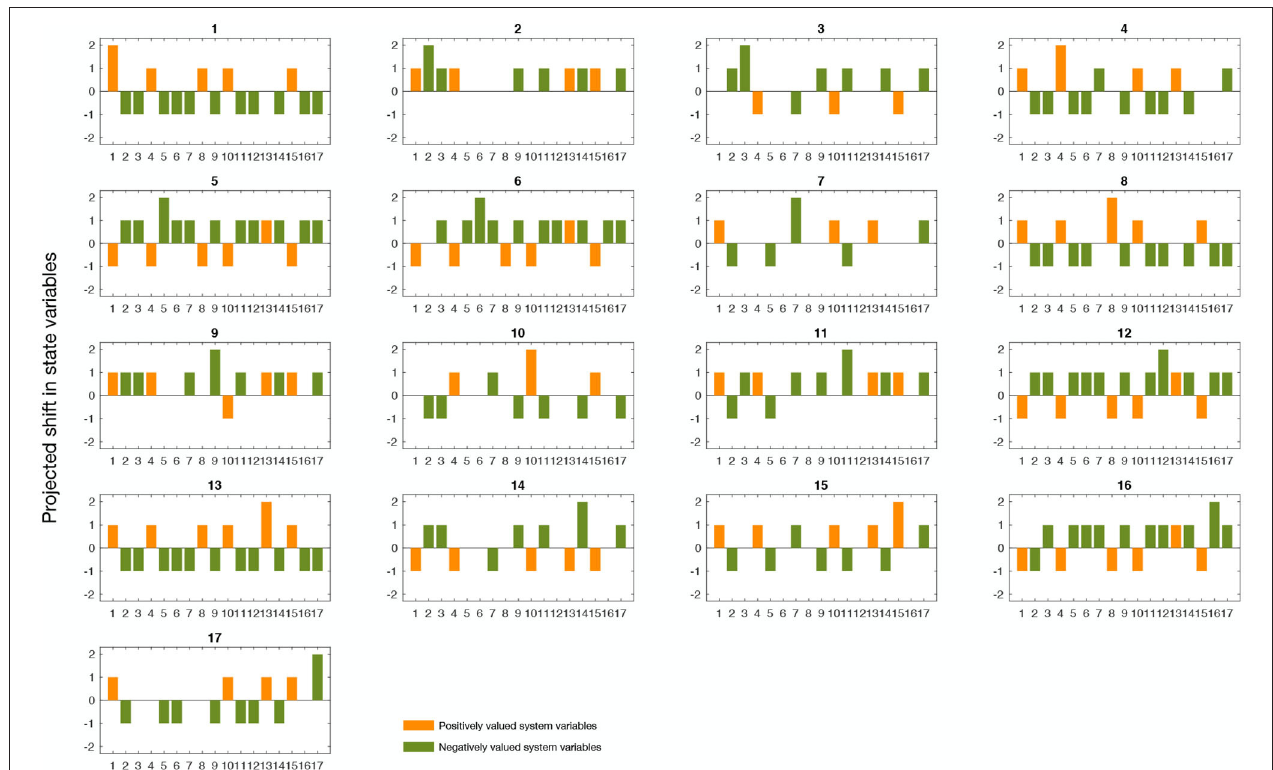
FIGURE 2 | Projected responses of state variables to sustained pressures on each single variable, which is numbered at the top of each plot. For example, the top left plot shows the projected categorical shift (1: weak, 2: strong) in the equilibrium level of each variable (1–17 on x-axis) after externally increasing the level of variable 1. Green/orange bars represent variables with positive/negative normative